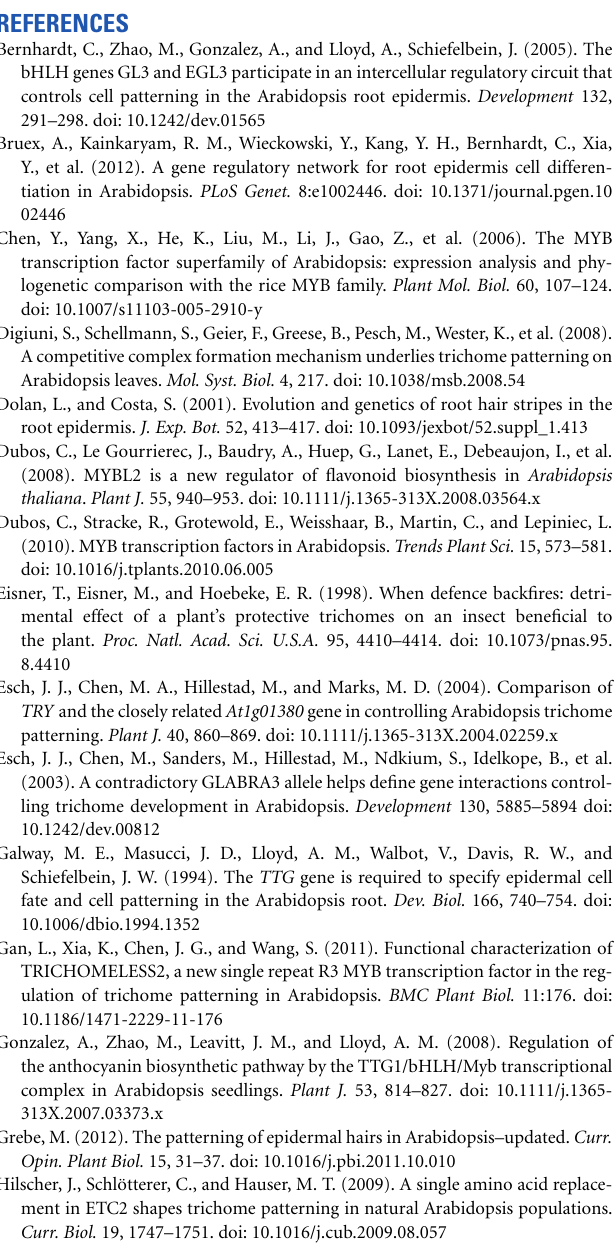
Figure S2 | Phylogenetic analysis of R3 MYBs with other MYBs. The entire amino acid sequences of single repeat R3 MYB transcription factors were used for phylogenetic analysis using tool on www.phylogeny.fr with default settings. Figure S3 | Amino acid similarity and identity of R3 MYBs and other MYBs. Figure S4 | Amino acid sequence alignment of ETC3 variants. Identical and similar amino acids are shaded in black and gray, respectively. The amino acids of [D/E]Lx 2 [R/K]x 3 Lx 6 Lx 3 R signature that is required for interaction between MYBs and R/B-like bHLH transcription factors are indicated by arrowheads on the top of amino acids. The amino acids of WxM motif that is crucial for cell-to-cell movement are indicated by arrowheads on the bottom of amino